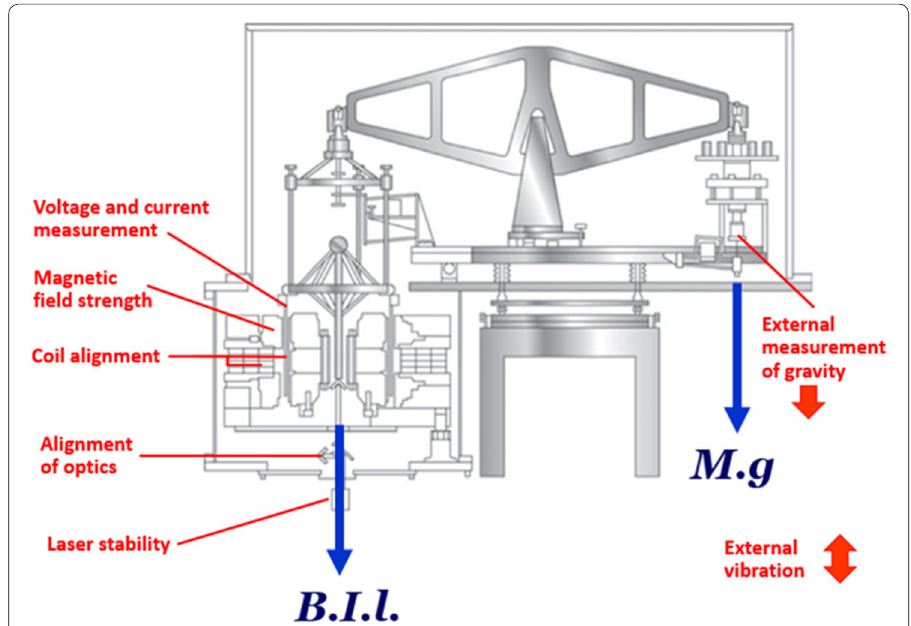
Fig. 3 Simplified schematic of a Kibble balance, equating electromagnetic (